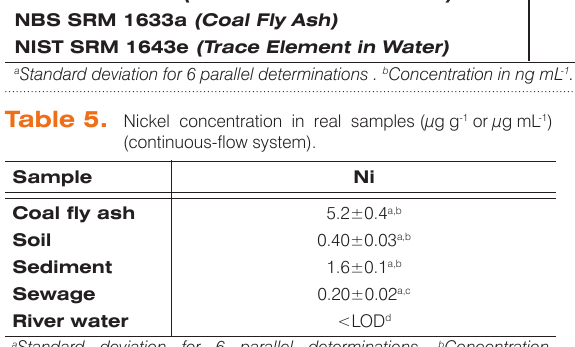
in μg g -1 . c Concentration in μg mL -1 . d Below limit of detection.